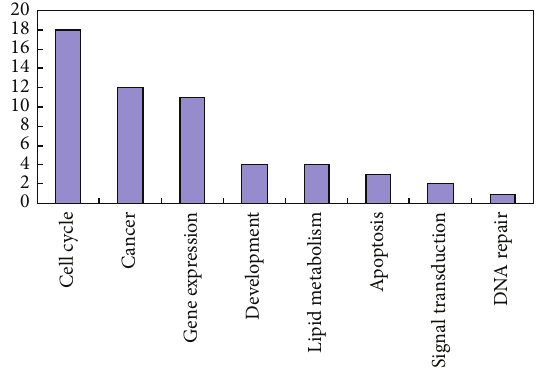
Figure 2: The frequency of fifty-five pathways. Fifty-five pathways canbecataloguetoeightclassesincludingcellcycle,geneexpression, lipid metabolism, cancer, apoptosis, signal transduction, develop- ment, and DNA